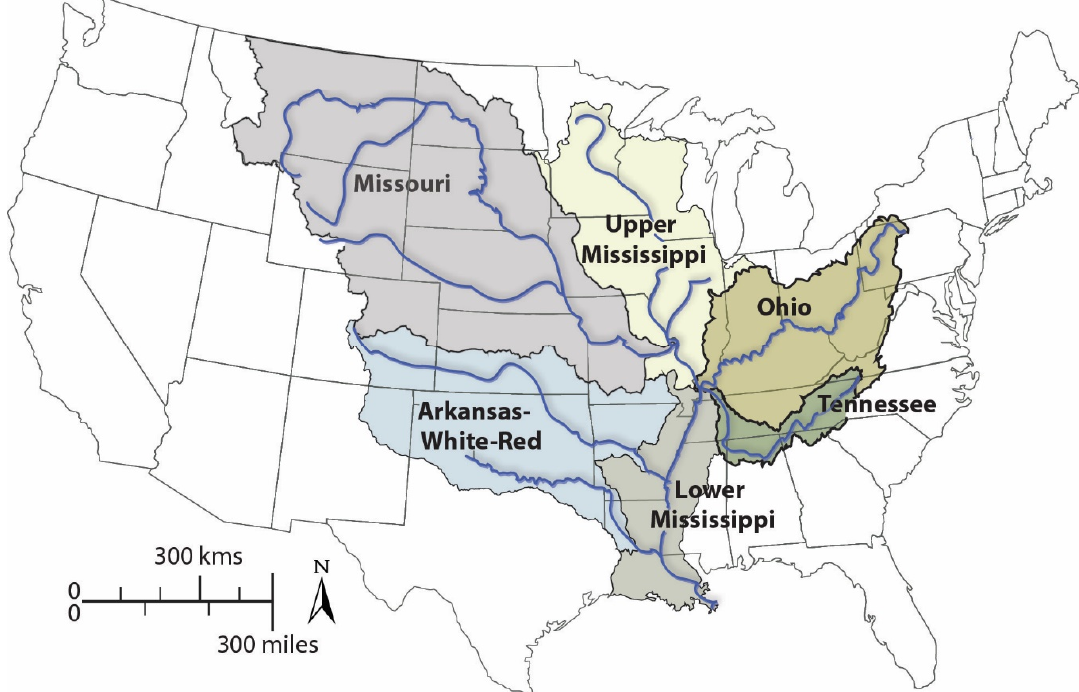
Figure 1. Location of the study area.